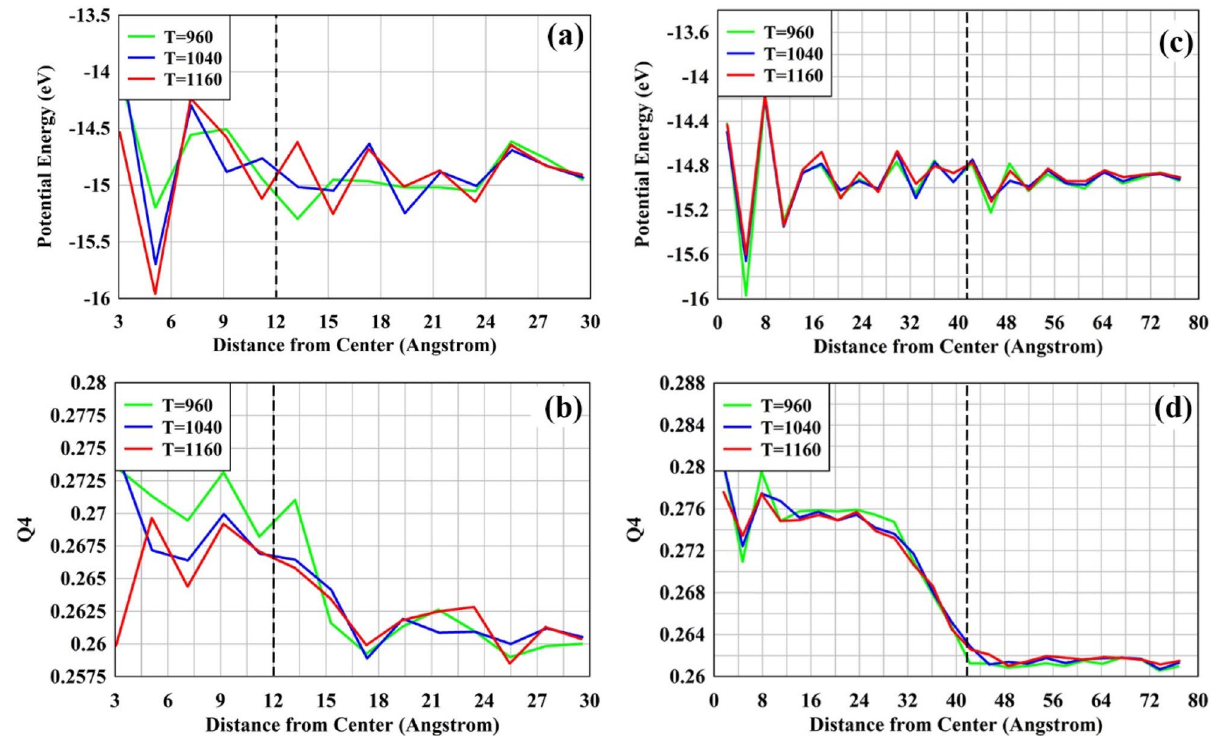
Figure 5. Potential Energy and bond-orientational order parameter Q4 as a function of distance from the center for a cluster with radius 12 ( a , b ) and 41 Å ( c , d ). The vertical dotted line represents the cluster radius (the right side of the dotted line is the melt). The bin size for the 12 and 41 Å clusters are 2 and 3 Å respectively. The first couple of points in each of these plots have numerical artifacts from the binning